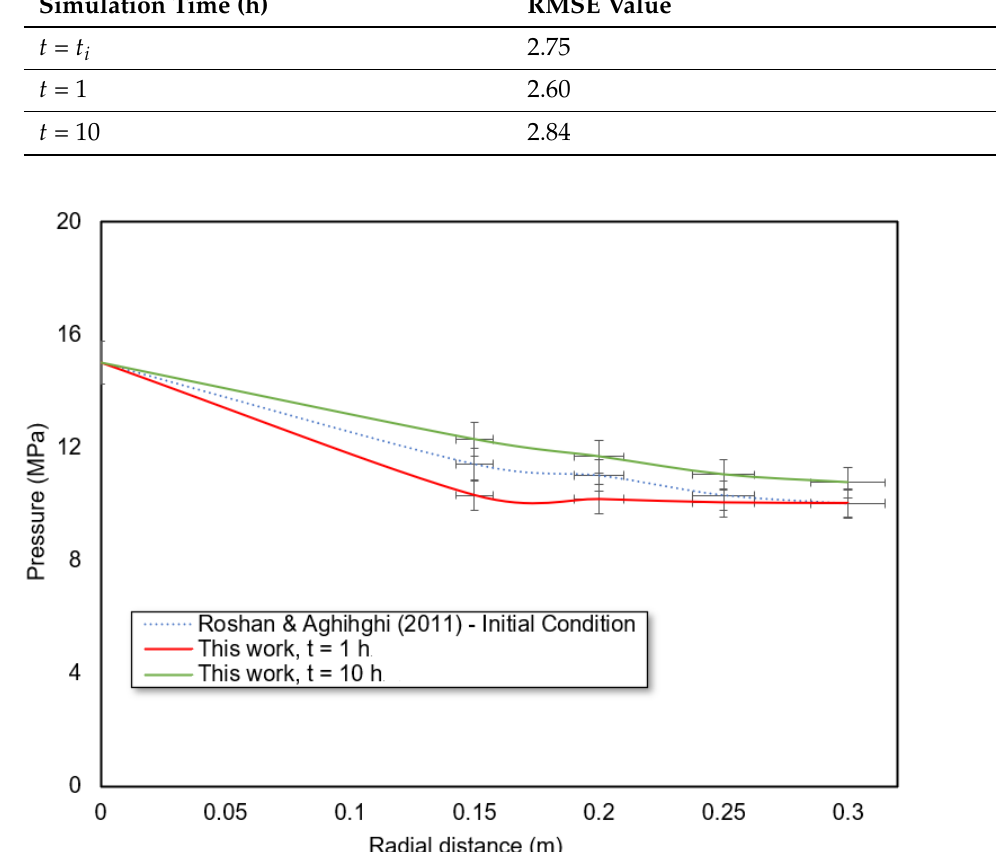
Figure 13. Comparison of the computed pore-pressure dissipation near the wellbore for CSMP++ and [12] for the 2D chemo-poroelasticity